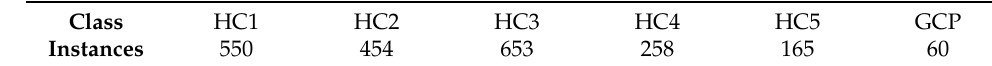
Table 3. Object distribution by